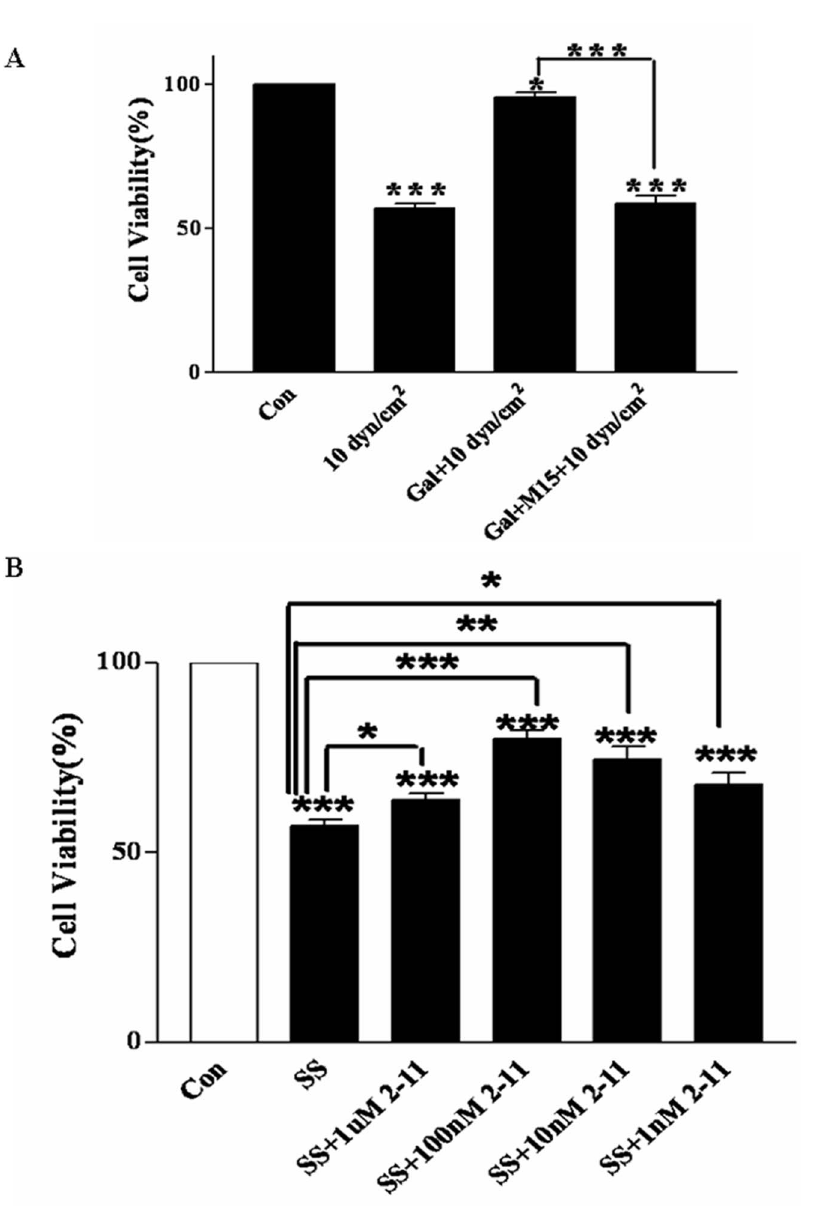
Figure 3. Involvement of GalR2 in the protective effects of galanin against shear stress-induced neurotoxicity. A) Galantide (M15), a galanin receptor antagonist, blocks the protective effects of galanin after shear stress of 10 dyn/cm 2 for 12 h. B) Gal2-11, a galanin receptor 2/3 agonist, and pretreatments of 1 m M, 100 nM, 10 nM of the galanin receptor 2/3 antagonist Gal2-11 show significant protective effects against shear stress-induced nerve injury tested by MTT assay. * p , 0.05, ** p , 0.01 and *** p , 0.001 were considered to be statistically significant.